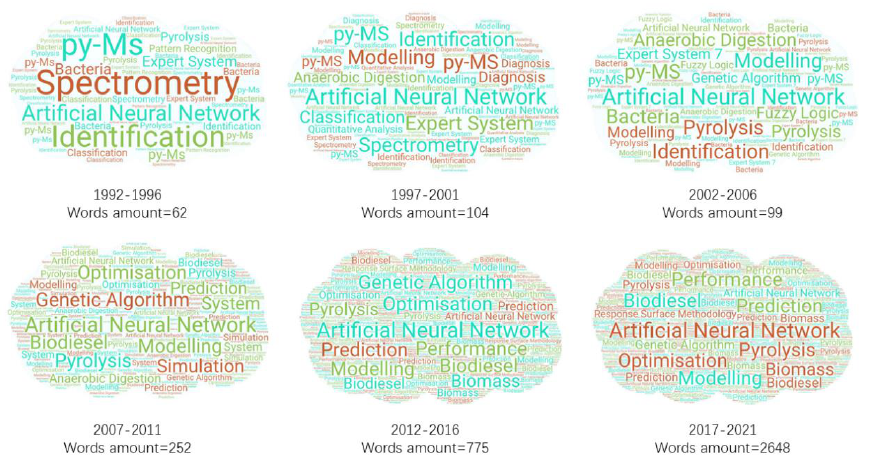
Figure 10. The occurrence frequency of the most used keywords in AI in bioenergy research from 1992 to 2021 for every five years.